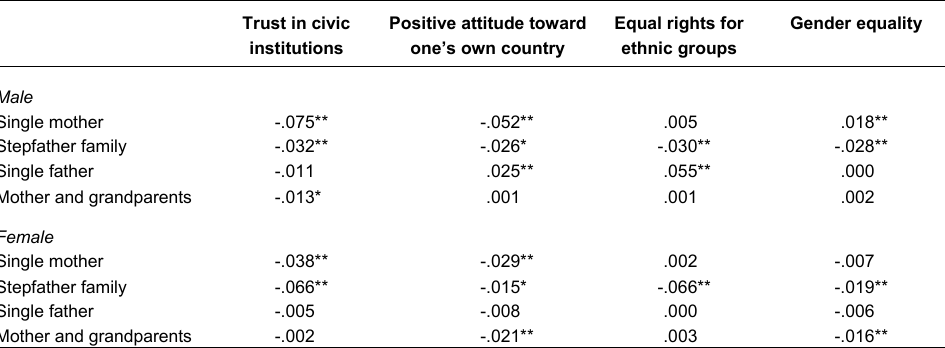
Table 3 : Societal attitudes of 13- and 14-year-old male and female native students in 22 different European countries: Deviations of the scores of students in two-parent families. OLS regression (standardized coefficients) Trust in civic Positive attitude toward Equal rights for Gender institutions one’s own country ethnic groups